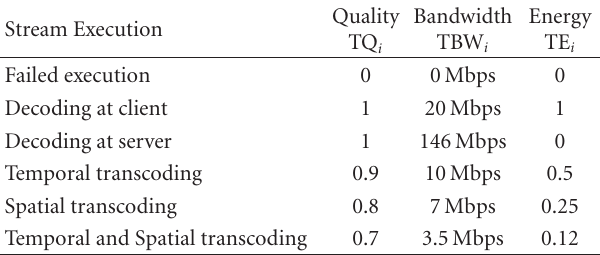
Table 1: Definition of task execution costs (SD